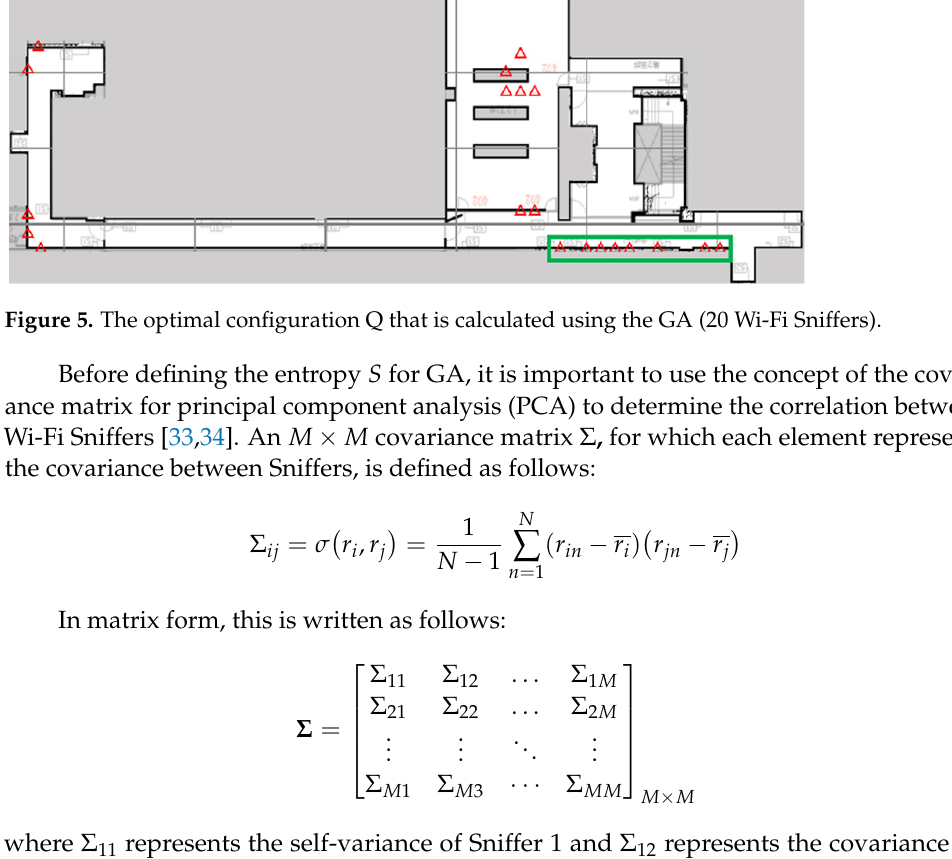
Table 1. Parameters used in genetic algorithm. Parameters Value Number of possible candidate locations for Sniffers, R 133 Number of Sniffers required to be selected, M 20 Crossover rate 0.8 Mutation rate 0.02 Population size 200 Number of generations 600 RSSI max, RSSI max − 30 dB RSSI min, RSSI min − 80 dB After the crossover, the algorithm iterates over each index in the configuration to monitor mutation. If a mutation occurs, a number in the range of 1 to R (inclusive) is randomly selected to represent a new Sniffer location index in the original configuration. Using the smallest fitness value that is obtained at generation 290, the solution converges as shown in Figure 4a. The optimal deployment pattern of Wi-Fi Sniffers, as determined using GA, is shown by the red triangles in Figure 5. The GA gives a converged solution, but eight Wi-Fi Sniffers are placed in close proximity, as shown in the green box. In general, Wi-Fi Sniffers should be distant from each other so that each gives significantly distinct and useful information. Therefore, to maximise the contributions of each Wi-Fi Sniffer to the maximum number of RPs, entropy S is used to enhance the objective function of the GA in this study. Entropy is a common metric for machine learning because it measures the unpredictability or impurity of a system [28–32]. The more disordered or impure a feature is, the greater the amount of information that can be extracted from that feature to better discriminate between Sniffers.